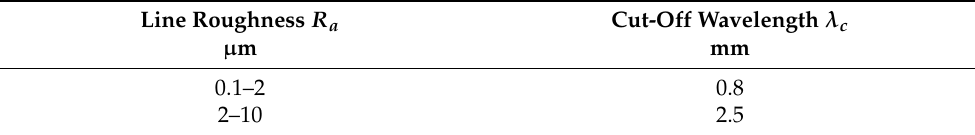
Table 5. Recommended cut-off wavelength λ c for non-periodic profiles depending on the expected line roughness R a according to ISO4288